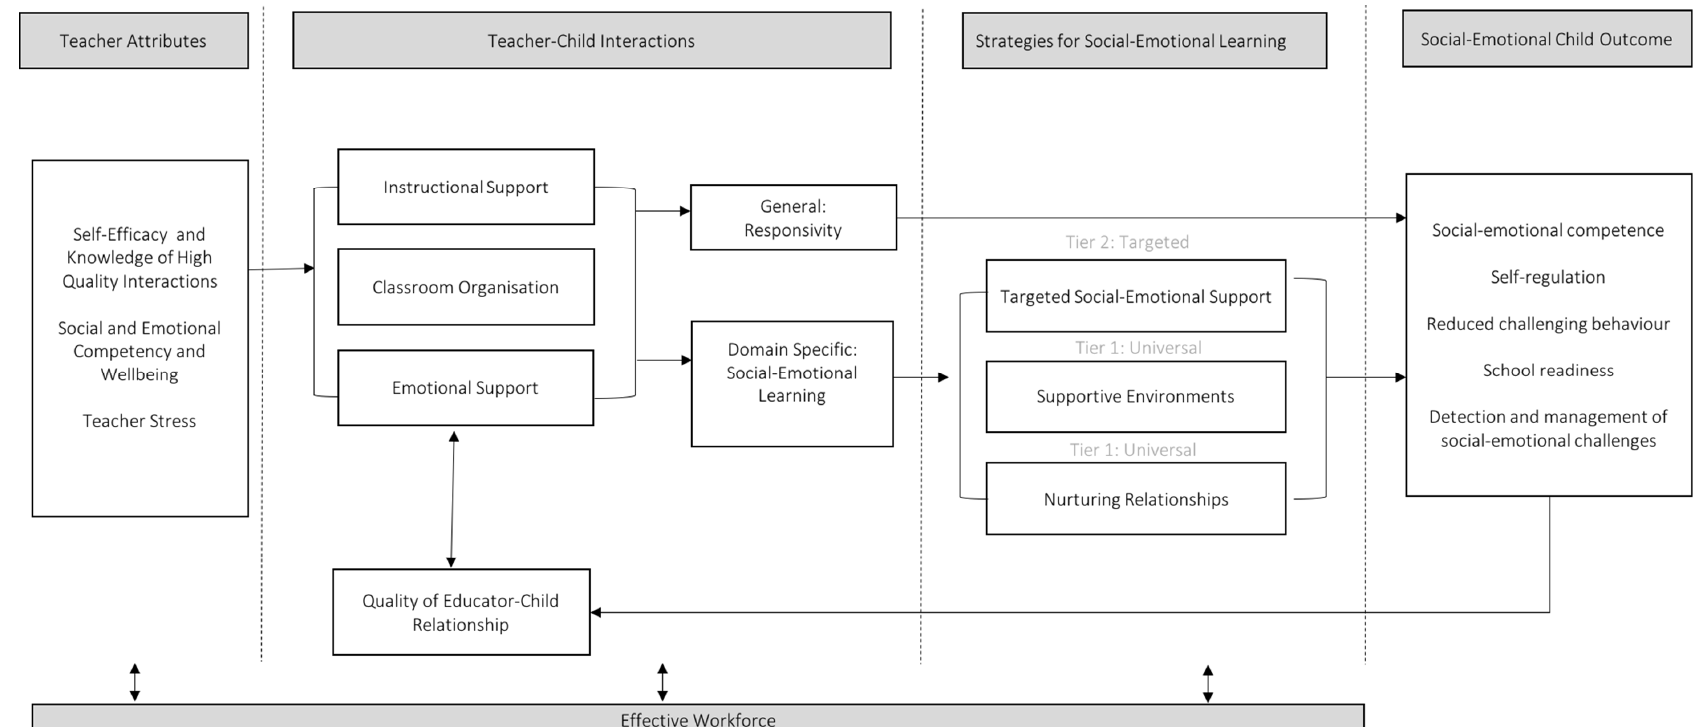
Figure 2. A Conceptual Model to Foster Social-Emotional Learning in Preschool Children by Targeting the Quality and Intentionality of Teacher–Child Interactions.